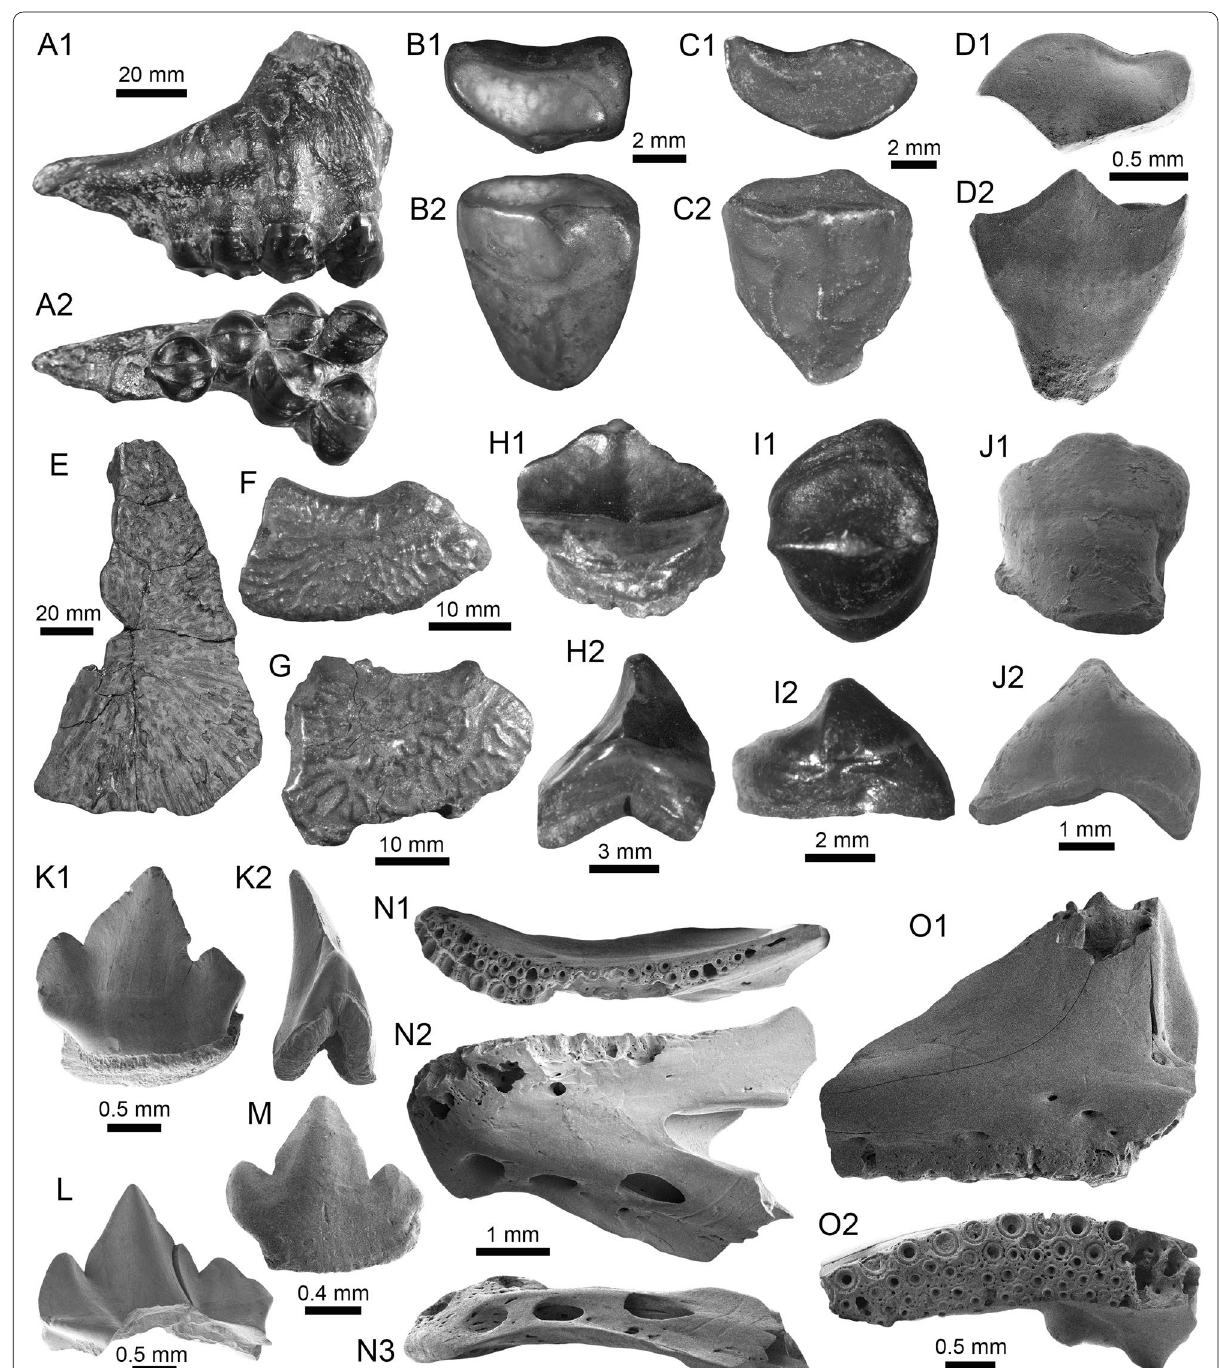
Fig. 4 Characiformes and Cichliformes fishes from the Iquitos assemblage. A1 – C2 Right premaxillary ( A1 – A2 : PIMUZ A/I 4810), and symphyseal teeth ( B1 – B2 : PIMUZ A/I 4812; C1 – C2 : PIMUZ A/I 4813A) of Colossoma cf. C . macropomum . D1 – D2 Symphyseal mandibular tooth of cf . Mylossoma sp. (PIMUZ A/I 4818). E – J2 left operculum ( E : PIMUZ A/I 4811), circumorbital ( F ) and frontal? ( G ) bones (PIMUZ A/I 5009), and molariform‑like teeth of indet. “pacu” or “ Myleus ” clades ( H1 – H2 : PIMUZ A/I 4813B; I1–I2: PIMUZ A/I 5008; J1 – J2 : PIMUZ A/I 4814). K1 – L cf. Serrasalmus sp. teeth (PIMUZ A/I 4826). M Recent tooth of Serrasalmus neveriensis (PIMUZ A/I 5058). N1 – O2 Left dentary ( N1 – N3 : PIMUZ A/I 4979), and right premaxilla ( O1 – O2 : PIMUZ A/I 4981) of indet. cichlids. Views: dorsal ( G ), labial ( B2 , C2 , D2 , J1 , K1 , M ), lingual ( H1 , L ), lateral ( F , H2 , I2 , J2 , K2 ), left lateral ( E , N2 ), right lateral ( A1 , O1 ), occlusal ( B1 , C1 , D1 , I1 , N1 ), and ventral ( A2 , N3 , O2